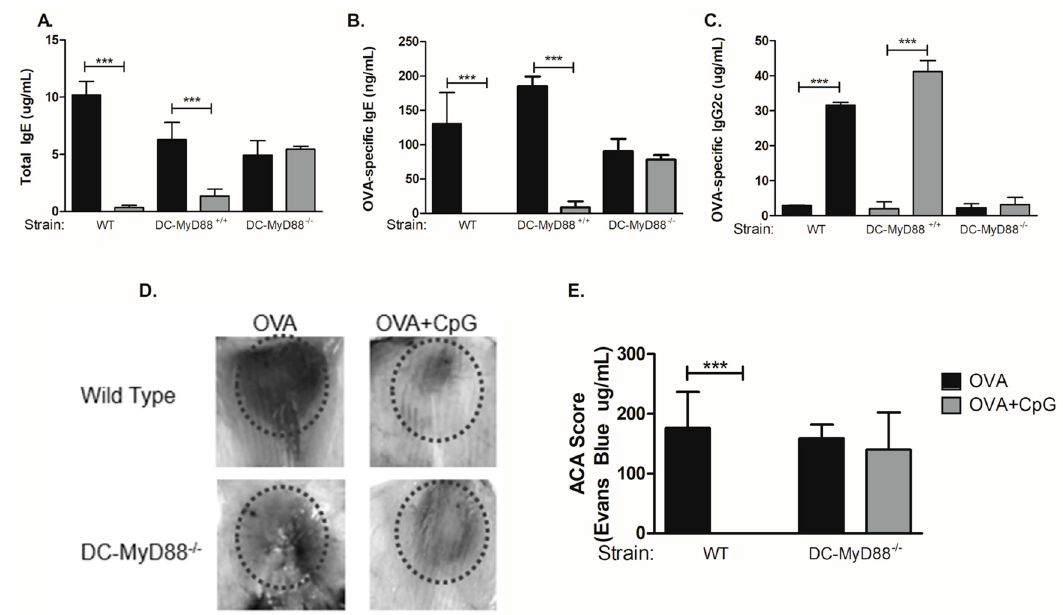
Figure 3. Myd88 expression on CD11c-positive cells mediates CpG-induced regulation of IgE and IgG2c production. C57BL / 6 wild-type (WT) or mice lacking total Myd88 expression on CD11c-positive dendritic cells (DC-MyD88 − / − ) or their control littermates (DC-MyD88 +/+ ) mice were subcutaneously sensitized with either ovalbumin (OVA) or OVA plus CpG using alum as adjuvant on days 0 and 7 and challenged intranasally with OVA on days 14 and 21. Experiments were performed on day 22. Serum levels of ( A ) Total IgE, ( B ) OVA-specific IgE or ( C ) OVA-specific IgG2c were measured by ELISA. Active cutaneous anaphylaxis (ACA) assay measured by Evans blue dye extravasation upon intradermal OVA injection was determined on day 21. ( D ) Representative skin pictures of Evans blue extravasation and ( E ) ACA score determined by measuring Evans blue extracted from the tissue. OVA groups ( n = 5) and OVA + CpG groups ( n = 5). Values represent the mean ± SD and are representative of two independent experiments. One-way ANOVA: *** p < 0.001.